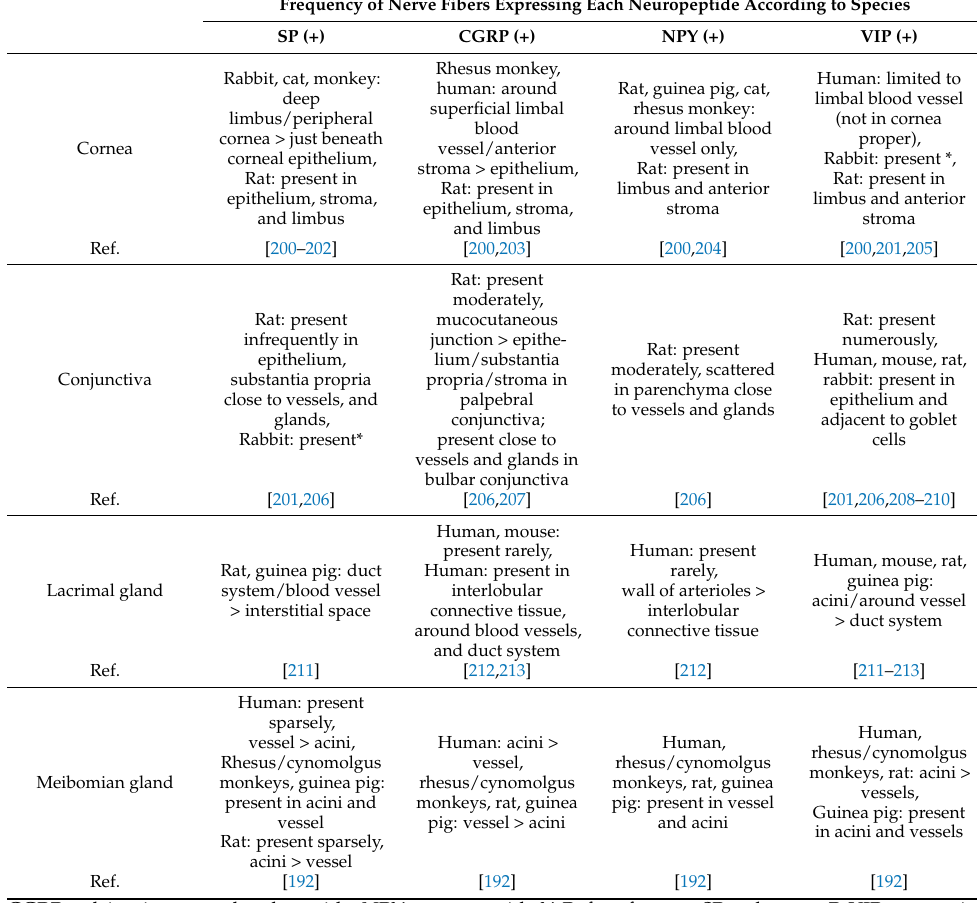
Table 2. Distribution of nerve fibers expressing specific neuropeptides in the lacrimal functional unit according to